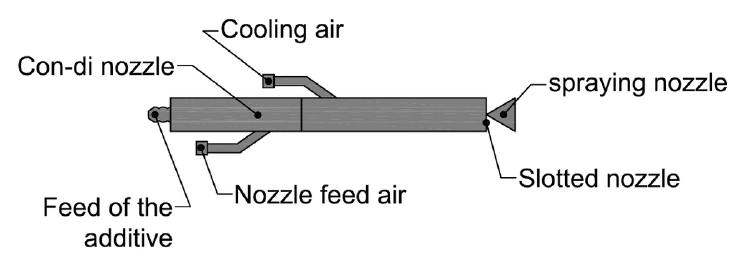
Figure 5. Splash nozzle for dry sorbent distribution.